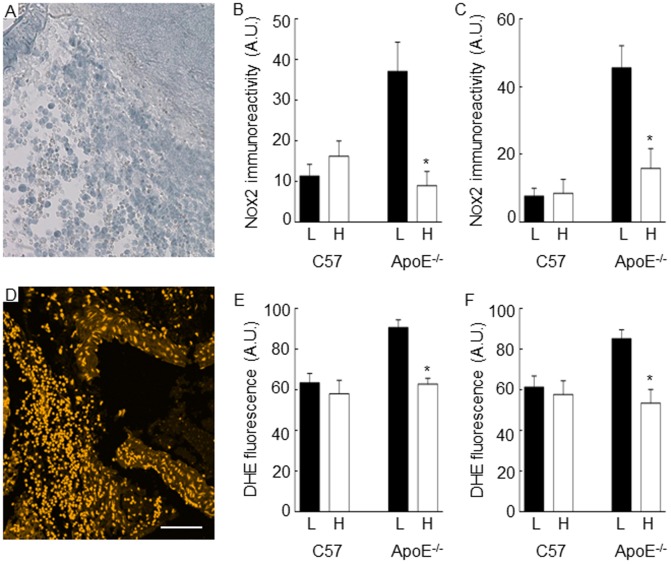
Quantitation of Nox2-immunoreactivity and superoxide production in inflammatory cells infiltrating the abdominal aorta of C57 saline-infused, and apolipoprotein E-deficient (ApoE-/-) angiotensin II-infused mice.Mice were fed a low or high omega-3 polyunsaturated fatty acid (n-3 PUFA) diet for 8 weeks. NOX2 immunoreactive staining was evident in infiltrating inflammatory cells of ApoE-/- angiotensin II-infused mice on the low diet (A). Expression levels of Nox2 were lower in the suprarenal (B) and infrarenal aorta (C) of ApoE-/- angiotensin II-infused mice that received the high, compared to the low n-3 PUFA diet. Intense dihydroethidium (DHE) fluorescence, a marker for superoxide, was detected in adventitial neutrophils of ApoE-/- angiotensin II-infused mice on the low diet (D). DHE fluorescence intensity was lower in the suprarenal (E) and infrarenal aorta (F) of ApoE-/- angiotensin II-infused mice that received the high, compared to the low n-3 PUFA diet. * P<0.05. L, low n-3 PUFA diet; H, high n-3 PUFA diet; A.U., Arbitrary units.